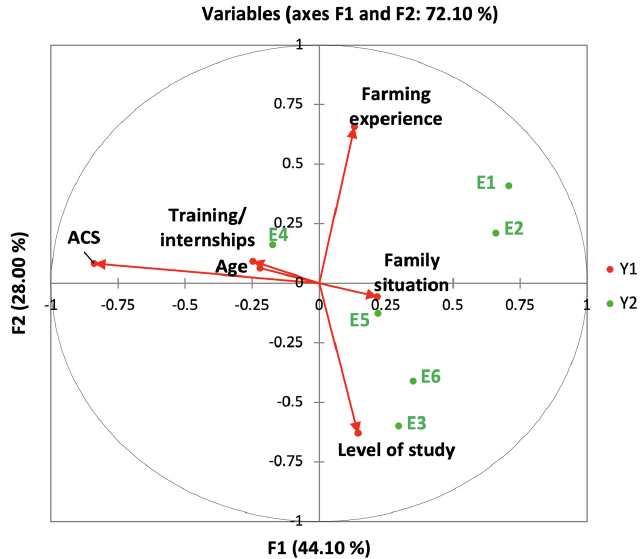
Figure 4. Biplot of behavior 2 and personal characteristics of the respondents’ canonical analysis as constructed according to data collected. E1, use of waterproof gloves; E2, use of a hat; E3, use of boots; E4, use of masks; E5, use of masks with cartridges; E6, use of goggles; ACS, benefit from agricultural advisory services. The first two canonical axes (Y1 and Y2) are in the horizontal and vertical directions. Variables of personal demographic characteristics are represented by the arrows. The arrow direction indicates the correlation between each variable and the canonical axes. The arrow length shows the relative contribution of the variables to the axes and the protective behavior-personal socioeconomic characteristics relationship, this being the principle of canonical correspondence analysis.